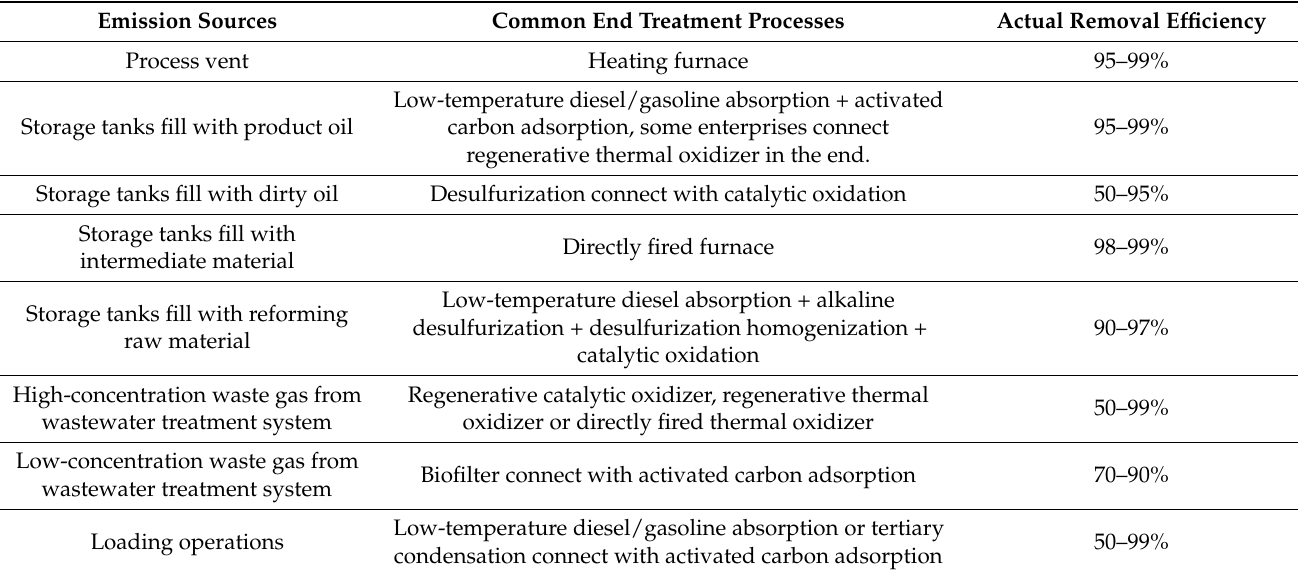
Table 6. Summary of the actual removal efficiency of treatment processes in the PR industry in